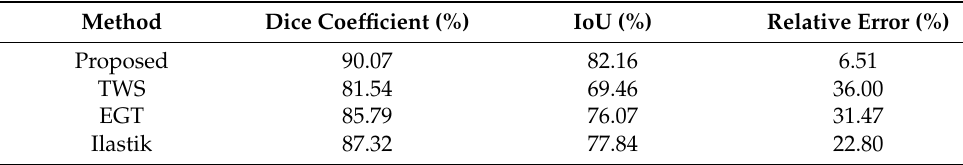
Table 1. Segmentation performance with different